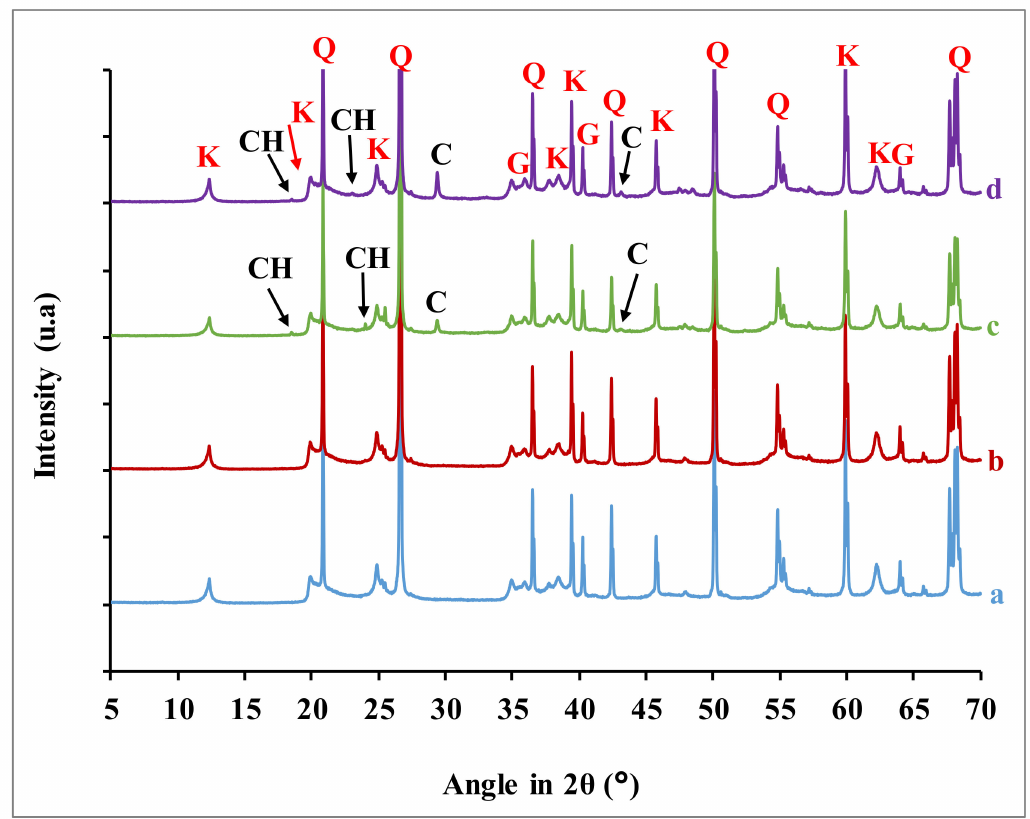
Figure 5. X-ray diffraction patterns of the earth renders samples. a) Raw earth renders; earth renders with b) 2 wt.% dolomitic lime, c) 4 wt.% dolomitic lime, and d) 6 wt.% dolomitic lime (K: kaolinite, Q: quartz, G: goethite, CH: portlandite, and C: